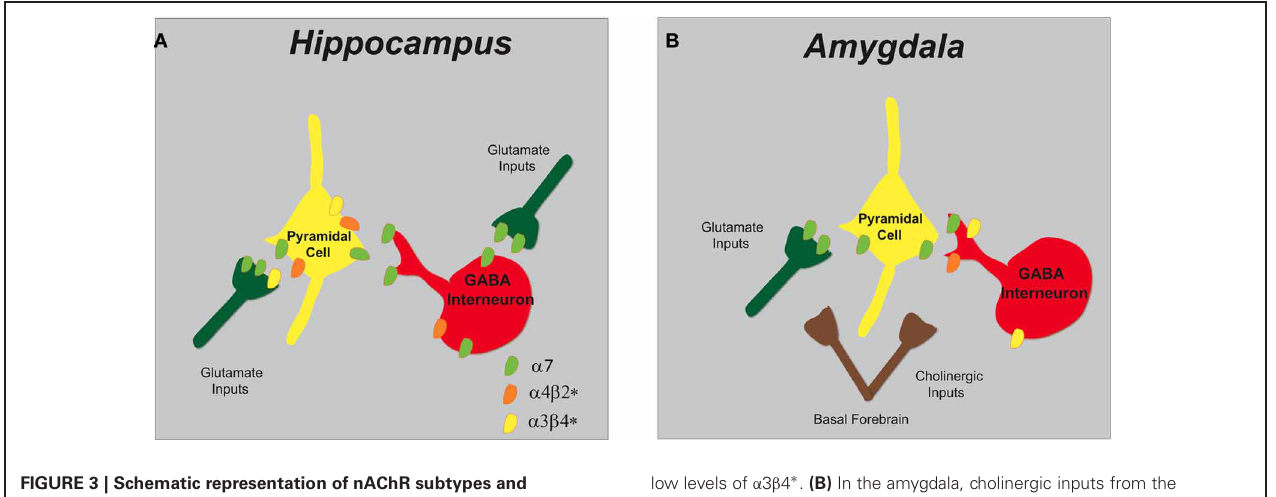
FIGURE 3 | Schematic representation of nAChR subtypes and circuit function in the hippocampus and amygdala. (A) In the hippocampus, α 7 and α 4 β 2 ∗ nAChRs are abundantly expressed on pyramidal cells and inhibitory interneurons. GABAergic interneurons have pre-synaptic α 7 nAChRs and somato-dendritic expression of α 7 and α 4 β 2 ∗ nAChRs. Glutamatergic afferents have predominately pre-synaptic α 7 nAChRs and only